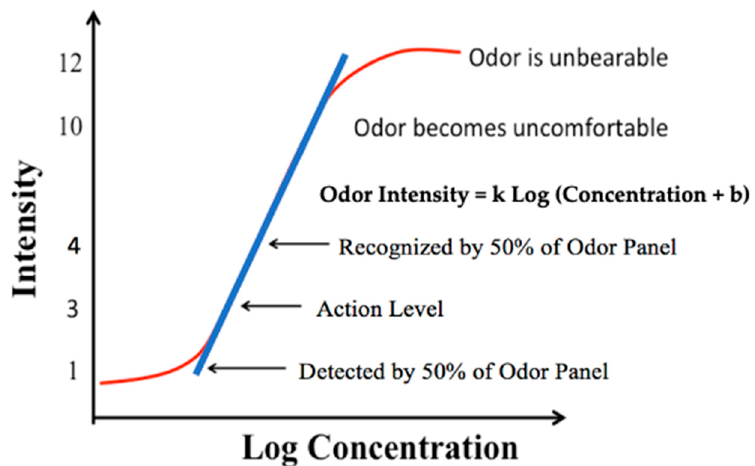
Figure 3. Weber–Fechner curve showing intensity vs. concentration. Note: The straight line represents the Weber–Fechner Law.